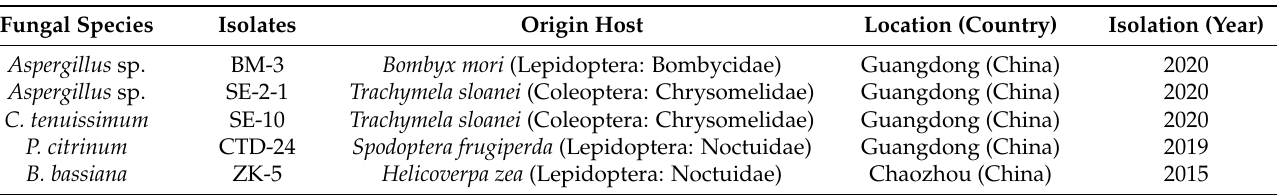
Table 1. Identity of entomopathogenic fungal isolates (EPFs) tested against eggs, larvae, and feeding performance of S. frugiperda .